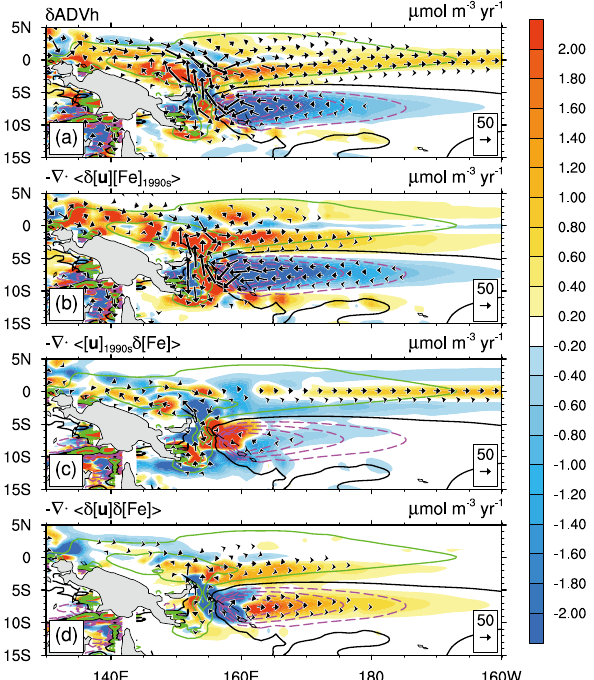
Fig. 12. The same as Fig. 9b, but showing the δ ADVh term (a) . Decomposition of δ ADVh using Eq. (8) (b–d) .